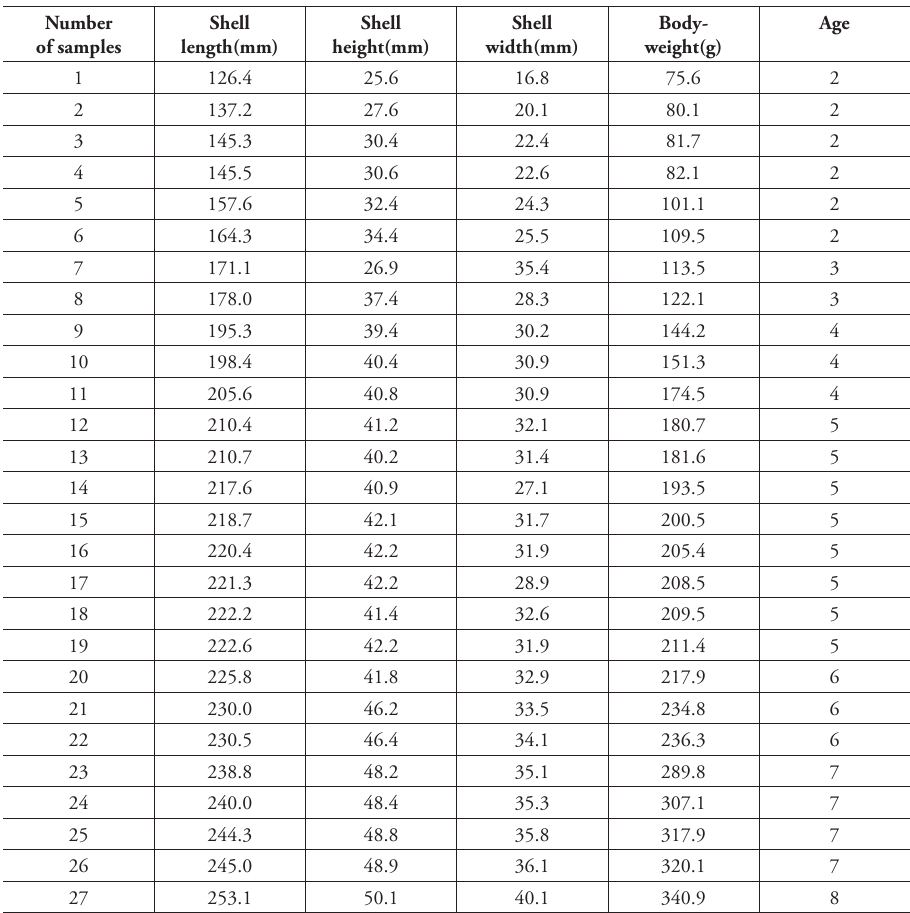
Table 1. Shell shape data and age structure of S. carinata. Number of samples